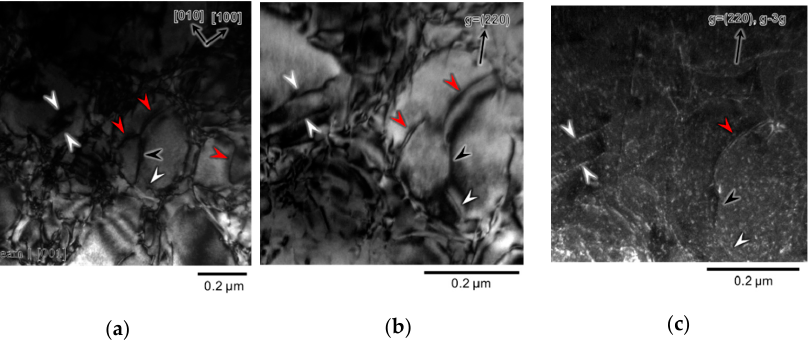
Figure 14. Images in the root of the ruptured specimen using TEM within the gauge of the ruptured specimen. Black arrows indicate <110> directed paired dislocation recognized from the view of [001]. White arrows indicate <100> directed paired dislocation recognized from the view of [001]. Red arrows mark wavy paired dislocation. ( a ) Bright-field image where the beam direction is parallel to [001], ( b ) bright-field image with g = (220), ( c ) weak beam image with g = (220).